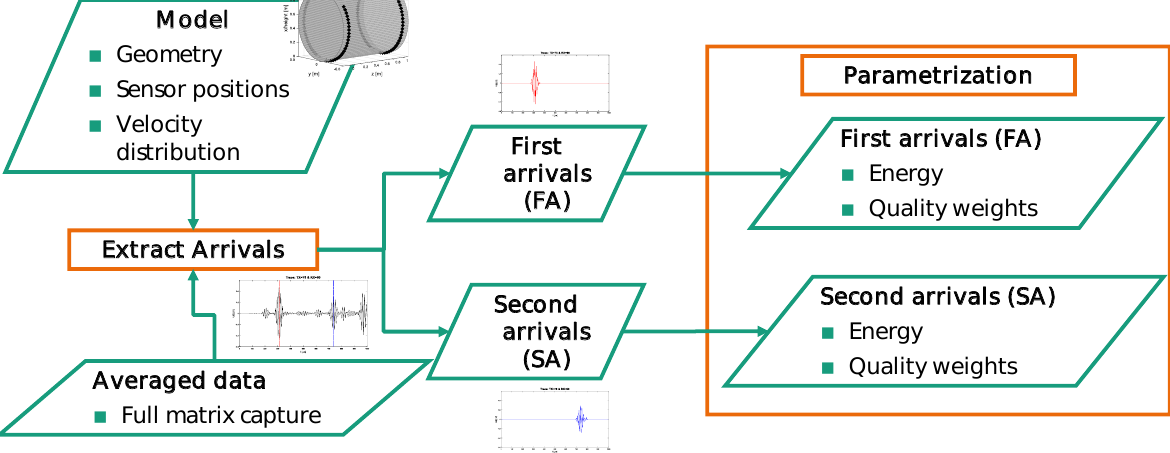
Figure 3. Schematic overview on the parametrization of the measured guided wave data. The first and second arrival of the fundamental antisymmetric lamb mode were extracted. Values deriving from time sections with interference of both arrivals, meaning overlapping α ( t ) sections, were related to appropriated weights w in the equation